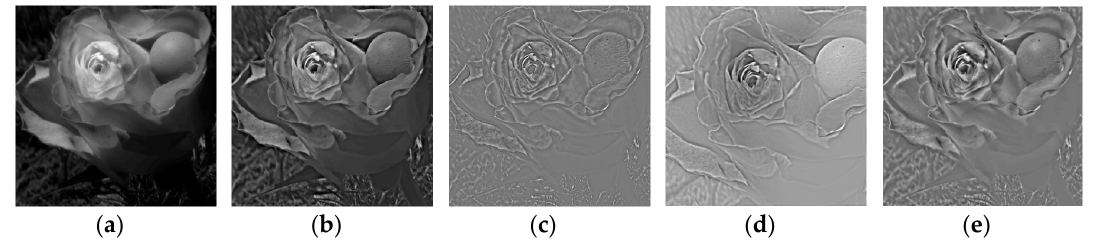
Figure 2. Example of spatial detail processing of the P image. ( a ) Original P image; ( b ) Enhanced P image. High-frequency images: ( c ) Sharpening + WLS filtering; ( d ) Sharpening + Gaussian filtering; ( e ) WLS filtering.